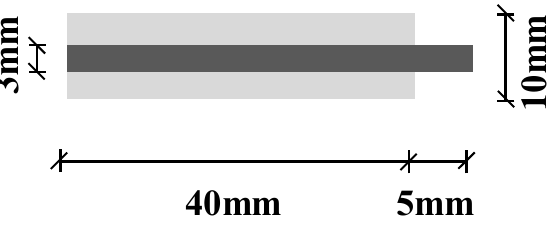
Figure 1. A schematic presentation of a specimen. Table 1. Chemical composition of the Q235 steel used in the study.